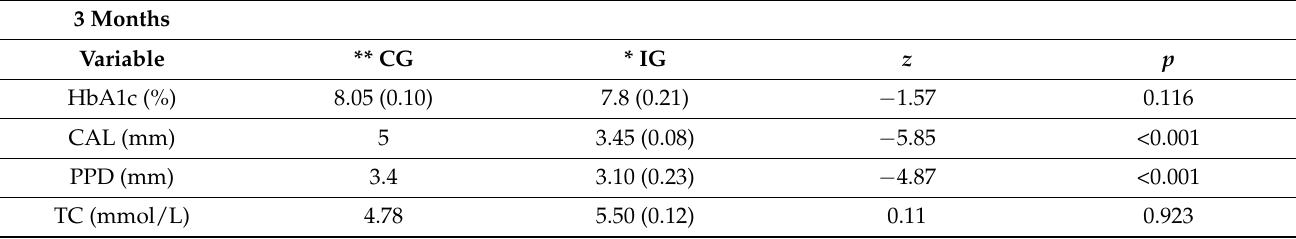
Table 2. Two-tailed Wilcoxon signed rank test results at 3 Table 1. Patient’s demographic and clinical characteristics at baseline.